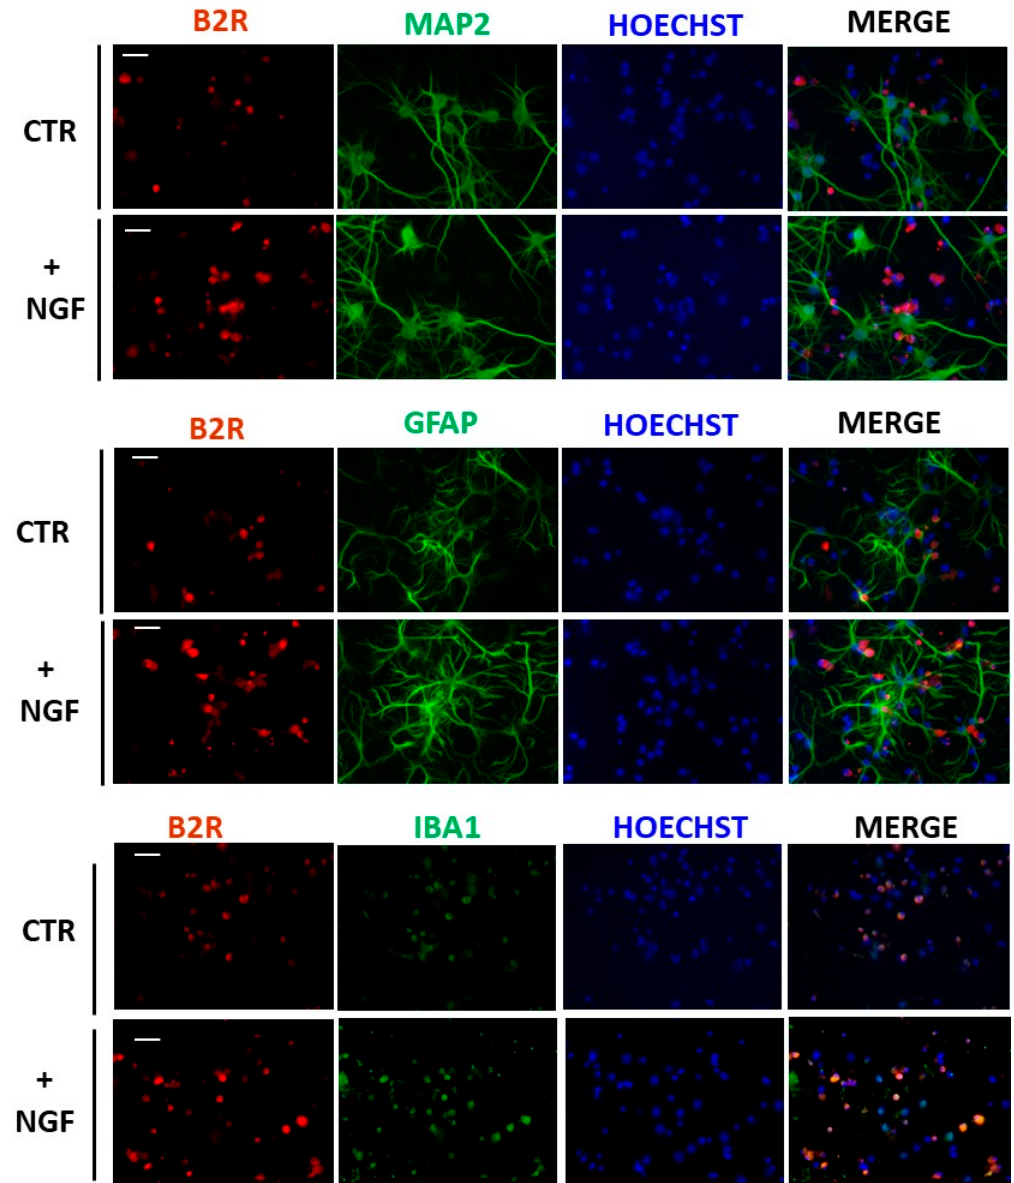
Figure 3. Expression of B2R in mixed cortical cultures. Representative immunofluorescence images of cultured CNs stained with antibodies for B2R (red), neurons (MAP2, green), astrocytes (GFAP, green), or microglial cells (Iba1, green) and nuclei (Hoechts, blue) in control conditions (CTR) and after NGF treatment (+NGF). B2R immunoreactivity significantly increased in microglial cell body after NGF treatment. Scale bar: 15 μ m.